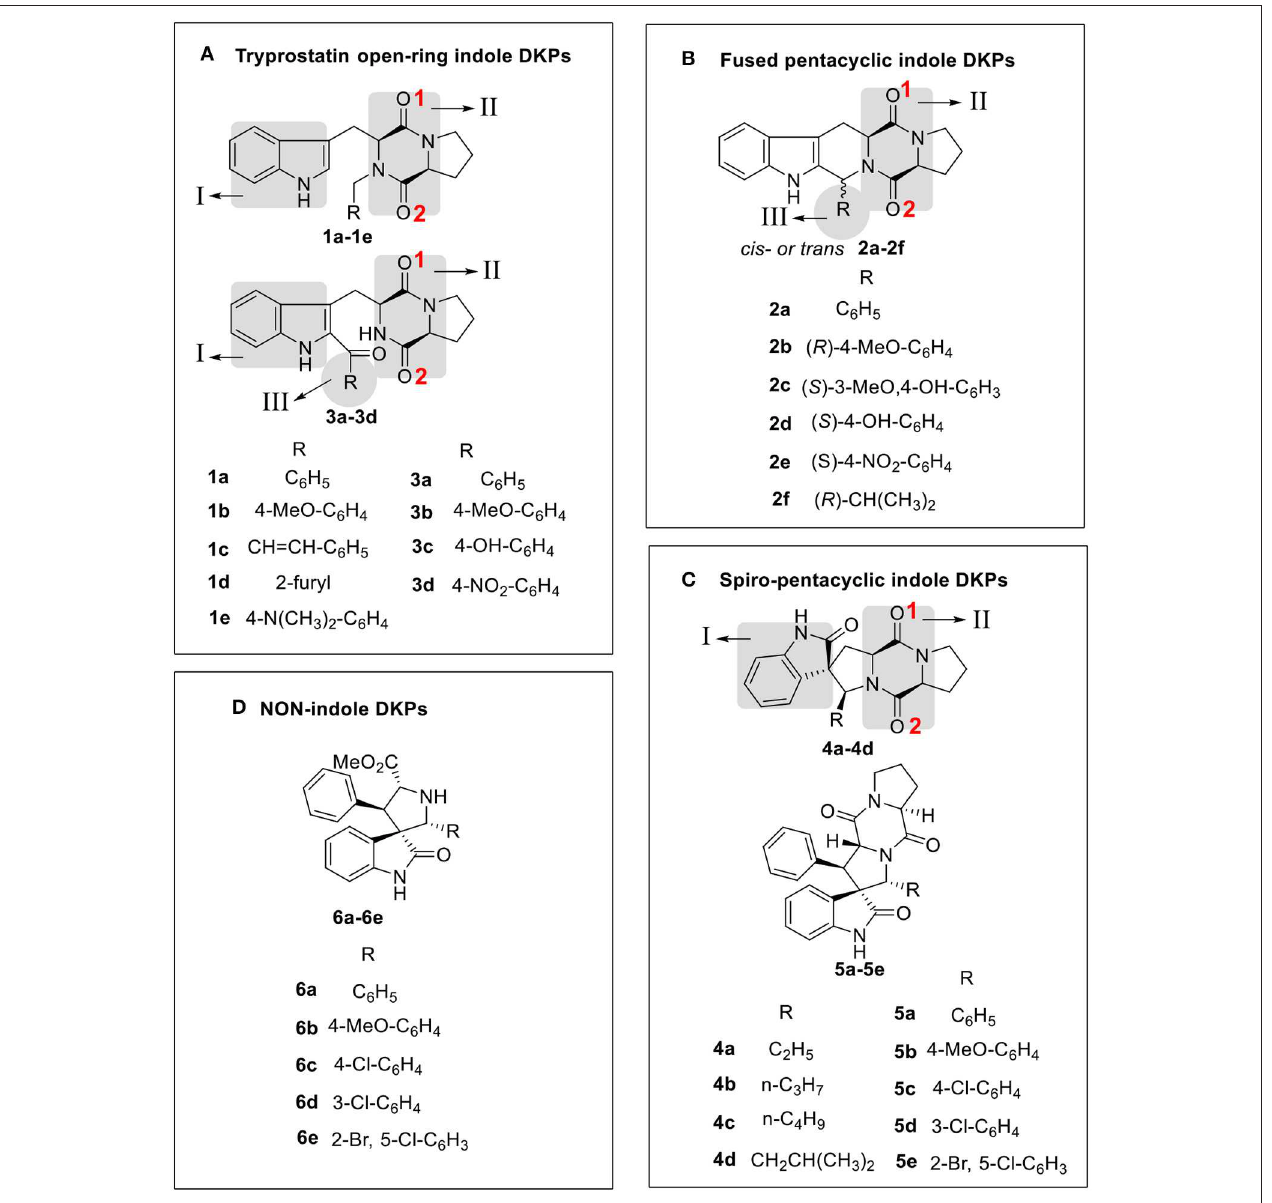
FIGURE 2 | Compound structure of three analogs of indole DKPs and indole analogs 6a − 6e , which were grouped into four framework categories (A–D) . These “I,” “II,” “III” represent three subunits of chemical structure of indole DKPs and “1,” “2” represent the position of Oxygen atom on the diketopiperazine